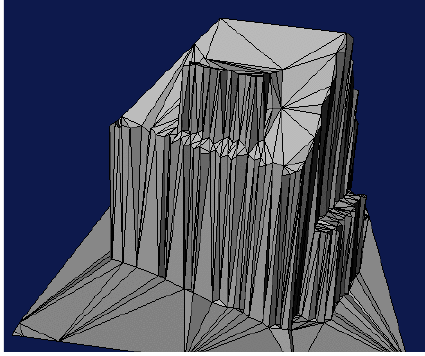
Fig. 8. Removal of vertices from intersection lines.